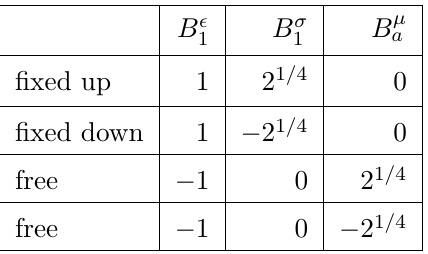
Table 3 . Solutions to the bulk-boundary sewing constraints for the fermionic Ising